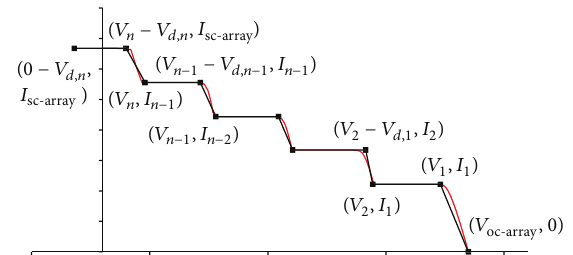
Figure 10: This figure shows the critical points of an array consisting 𝑛 series-connected basic modules.